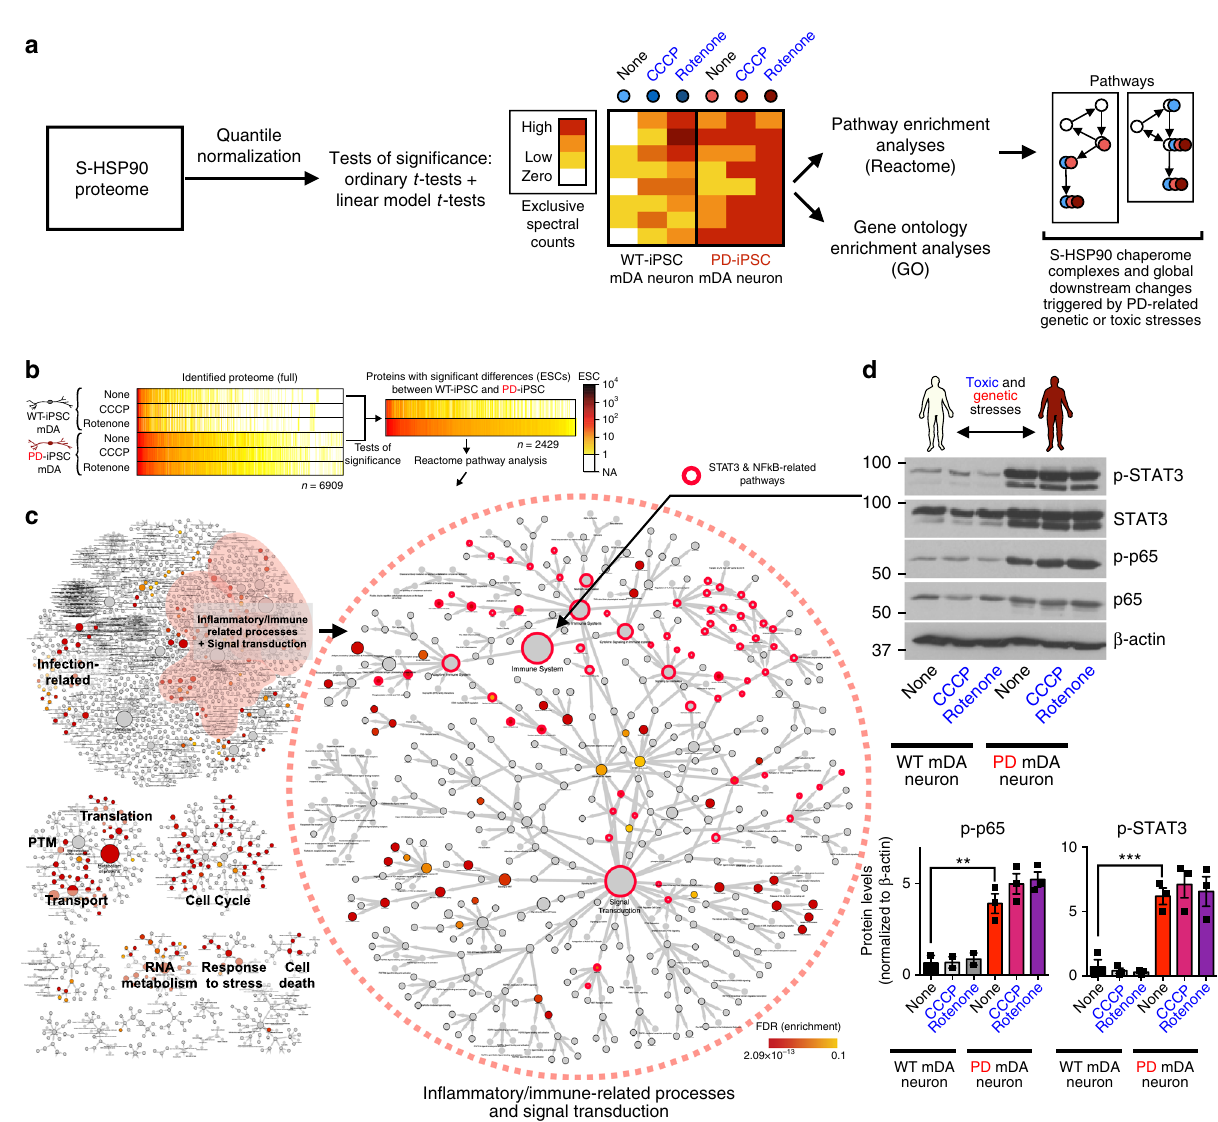
Fig. 4 Global analysis of proteins and protein networks enriched in response to PD-relevant genetic and toxic stress in hPSC-derived mDA neurons. a Schematic illustration of the experimental design for chemoproteomic studies and the identi fi cation and validation of proteins and protein pathways enriched in S-HSP90 complexes under each PD stress. See Supplementary Data 1 – 4 for protein lists, statistical analyses and results of Reactome and GO enrichment analyses. b Heatmap of S-HSP90 bound proteins indicating those signi fi cantly enriched in mDA neurons under genetic ( Parkin defect) stress. c Important cellular functions and pathways enriched under genetic stress. Inset shows the enrichment in in fl ammatory and signaling-related processes, with those incorporating STAT3 and NF-kB/p65-related pathways circled in red. (CCCP; 10 µ M; rotenone; 20 nM). d Western blot con fi rms an increase in STAT3 and NF-kB/p65-activity in PD over WT mDA neurons, irrespective of the additional toxic stress. Mean± SEM, n = 3 individual values from the different experiments shown as points, t -test, *** p < 0.001; ** p <